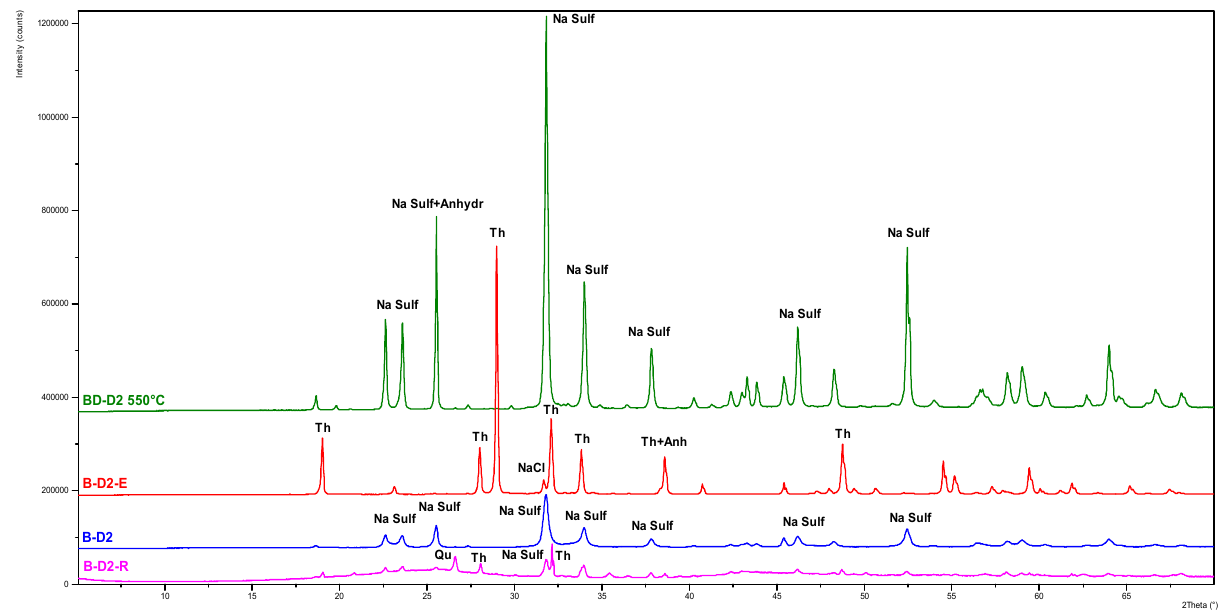
Figure 3. X-ray diffractograms of sample B-D2 after different treatments. Na Sulf = Na 2 SO 4 ; Anhydr = Anhydrite; Th = Thenardite; Qu = Quartz. Table 4. Results of the XRD investigation and semiquantitative assessment.